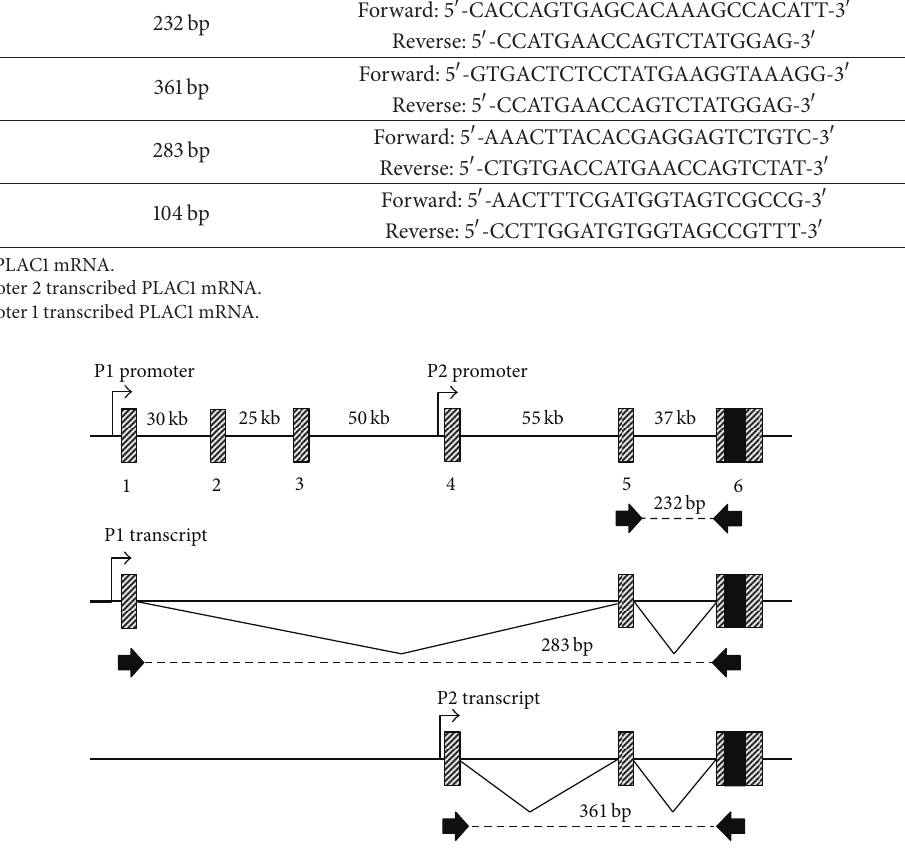
Figure 1: Genomic organization of the human PLAC1 gene on chromosome Xq26. The five 5 󸀠 UTR exons and the 5 󸀠 UTR and 3 󸀠 UTR components of Exon 6 are cross-hatched. The protein coding region in Exon 6 is the solid box. The P1 and P2 promoters are indicated relative to Exons 1 and 4 along with the composition of the P1 and P2 transcripts. Locations of the RT-PCR/qPCR primers in Table 2 are indicated along with their amplicon